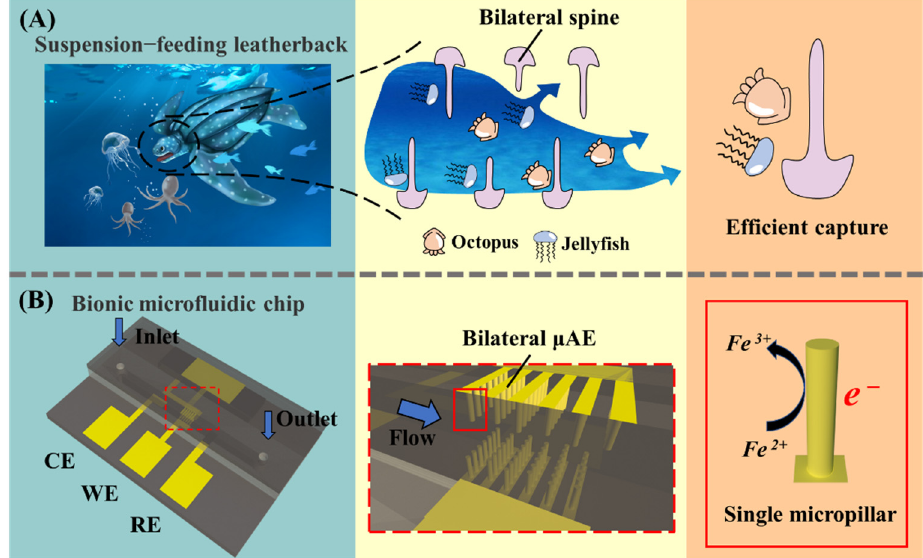
Figure 1. ( A ) The efficient capture mechanism of leatherback sea turtles, whose mouth and throat have bilateral projecting spines that can effectively grasp the free prey. ( B ) Electrochemical mechanism of the microfluidic chip. The micropillars are rearranged in bilateral sides of the microchannel, which increases the contact between the electrodes and analytes.